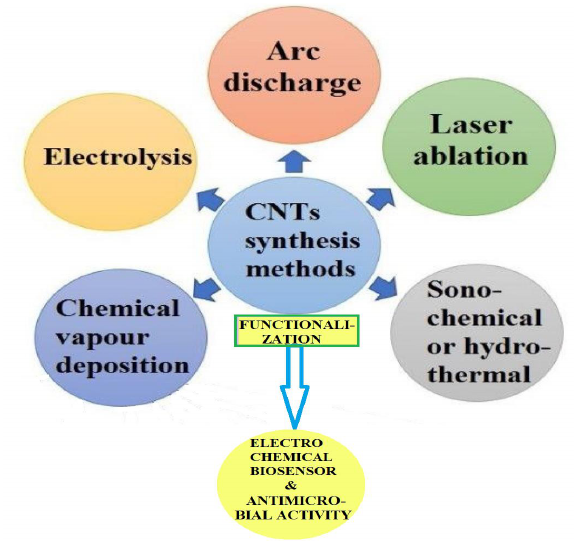
Figure 1. Carbon nanotube (CNT) preparation method and its potential application (our own original